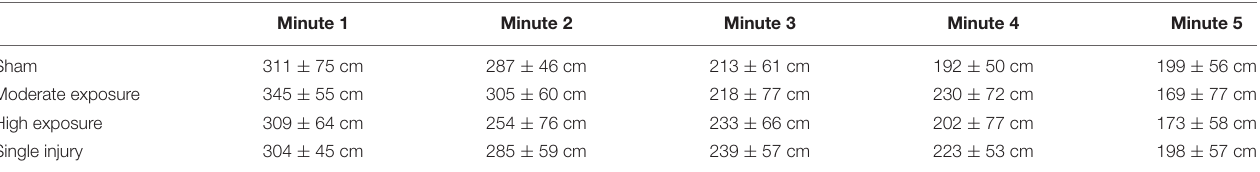
TABLE 1 | Distance traveled (cm) for each experimental group over the 5 min of the EPM assessment.